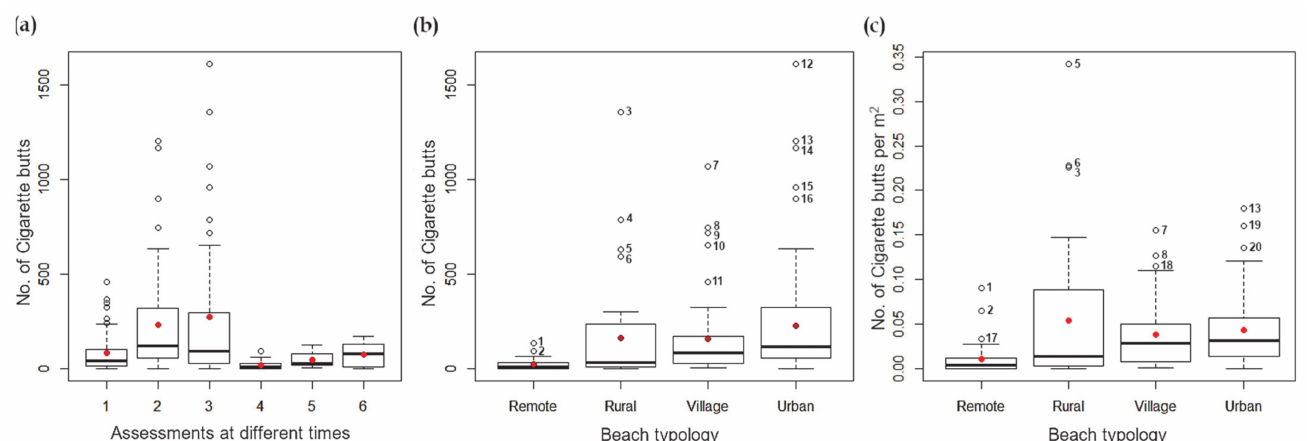
Figure 2. ( a ) Box plots of cigarette butts (CB) abundance according to different seasons: 1-Alacant-March/April 2018. 2-Alacant-August 2018. 3-C á diz-October 2018. 4-Ceuta-February 2019. 5-Ceuta-March 2019. 6-Ceuta-April 2019; ( b ) Box plots of CB per beach typology; ( c ) Box plots of CB/m 2 per beach typology. Boxes enclose 50% of data, associated standard deviations are represented with whiskers, averages with red dots, and median values with black lines. Outliers were marked from no. 1 to no. 20 (see Table 2 for more